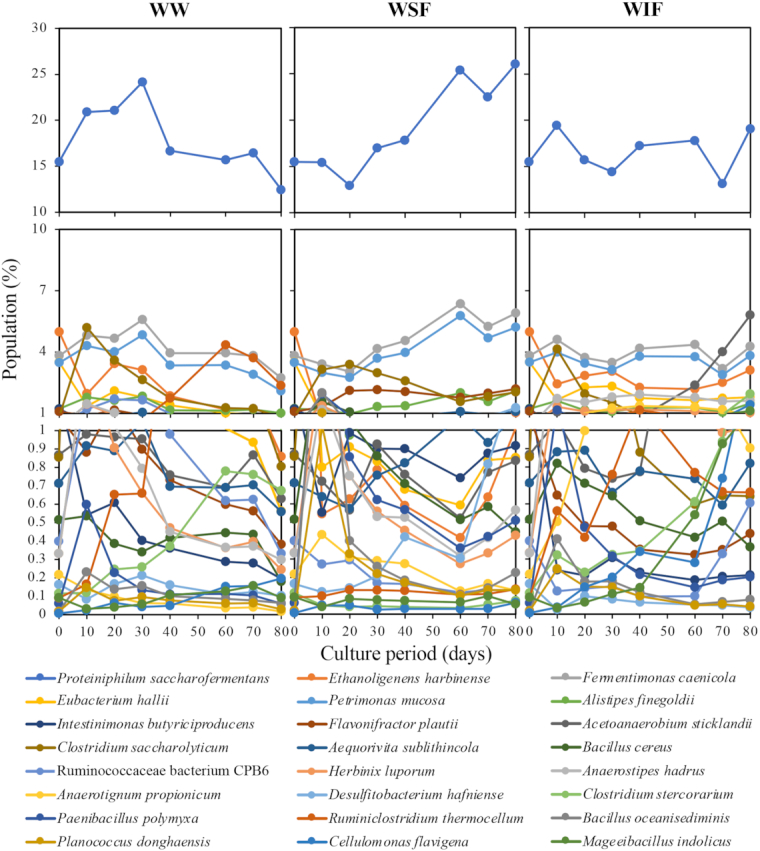
Changes in eubacterial population at the species level in the cultures shown in Fig. 1. Populations of the species that once exceeded 1% are indicated in every culture.